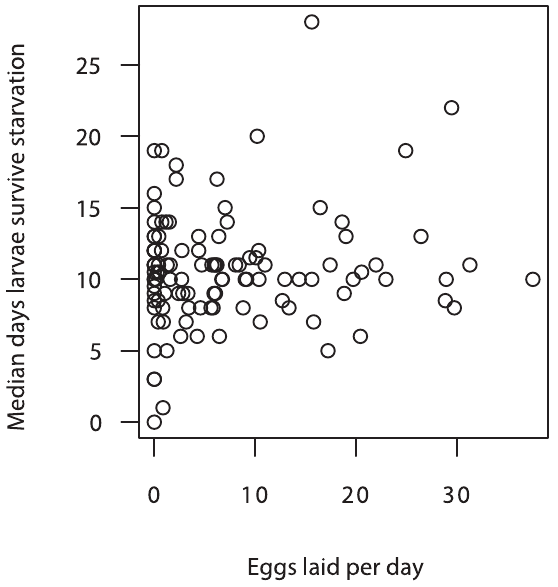
Figure 3. Median resistance to starvation vs. average number of eggs laid. Each circle represents an individual container (n=113 containers). Median resistance to starvation is the median number of days that larvae from a container survive without food. Number of eggs laid in that container was averaged over the three day survey period and divided by container circumference (mm).